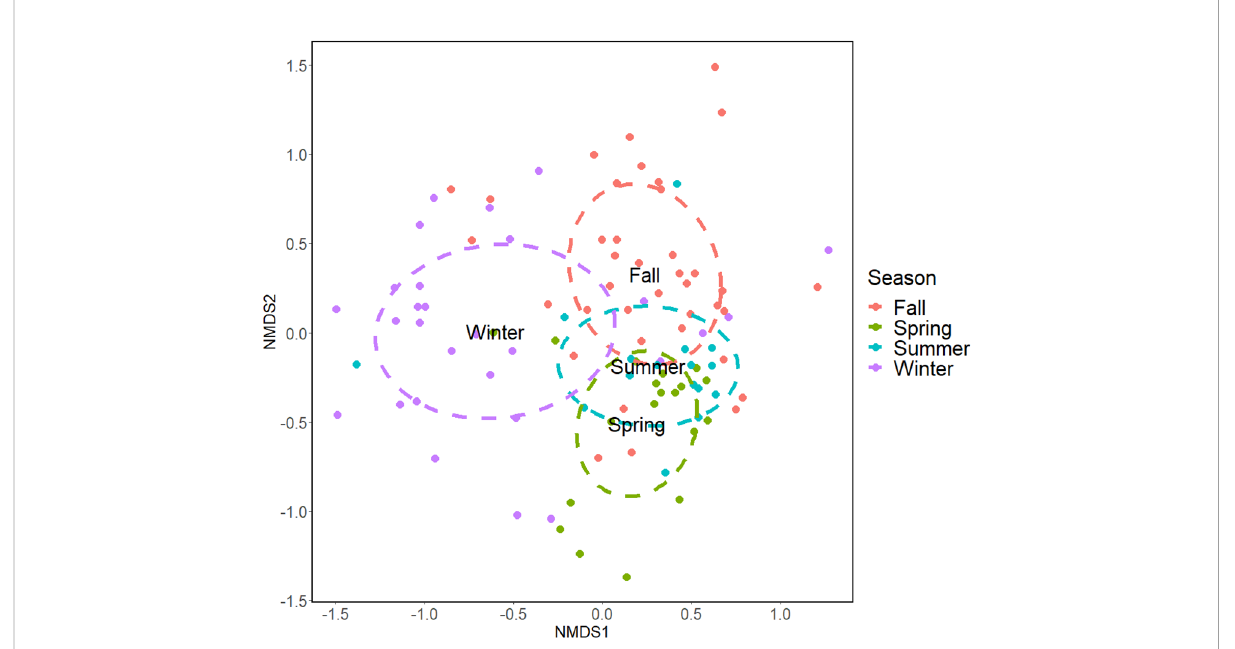
FIGURE 5 Non-metric Multidimensional Scaling of Venice Lagoon fi sh communities by seasons, according to eDNA metabarcoding. Graph produced starting with a Bray-Curtis distance matrix and calculated from the normalized OTU table. Samples collected in different seasons are shown in different colors (k = 3; Stress =